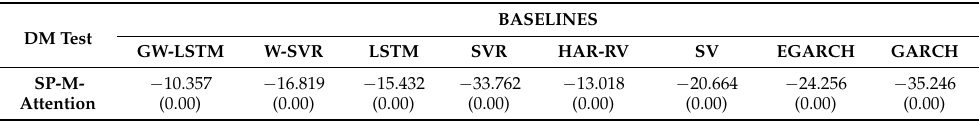
Table 6. The Diebold–Mariano (DM) test on volatility forecasting between SP-M-Attention and other baselines.